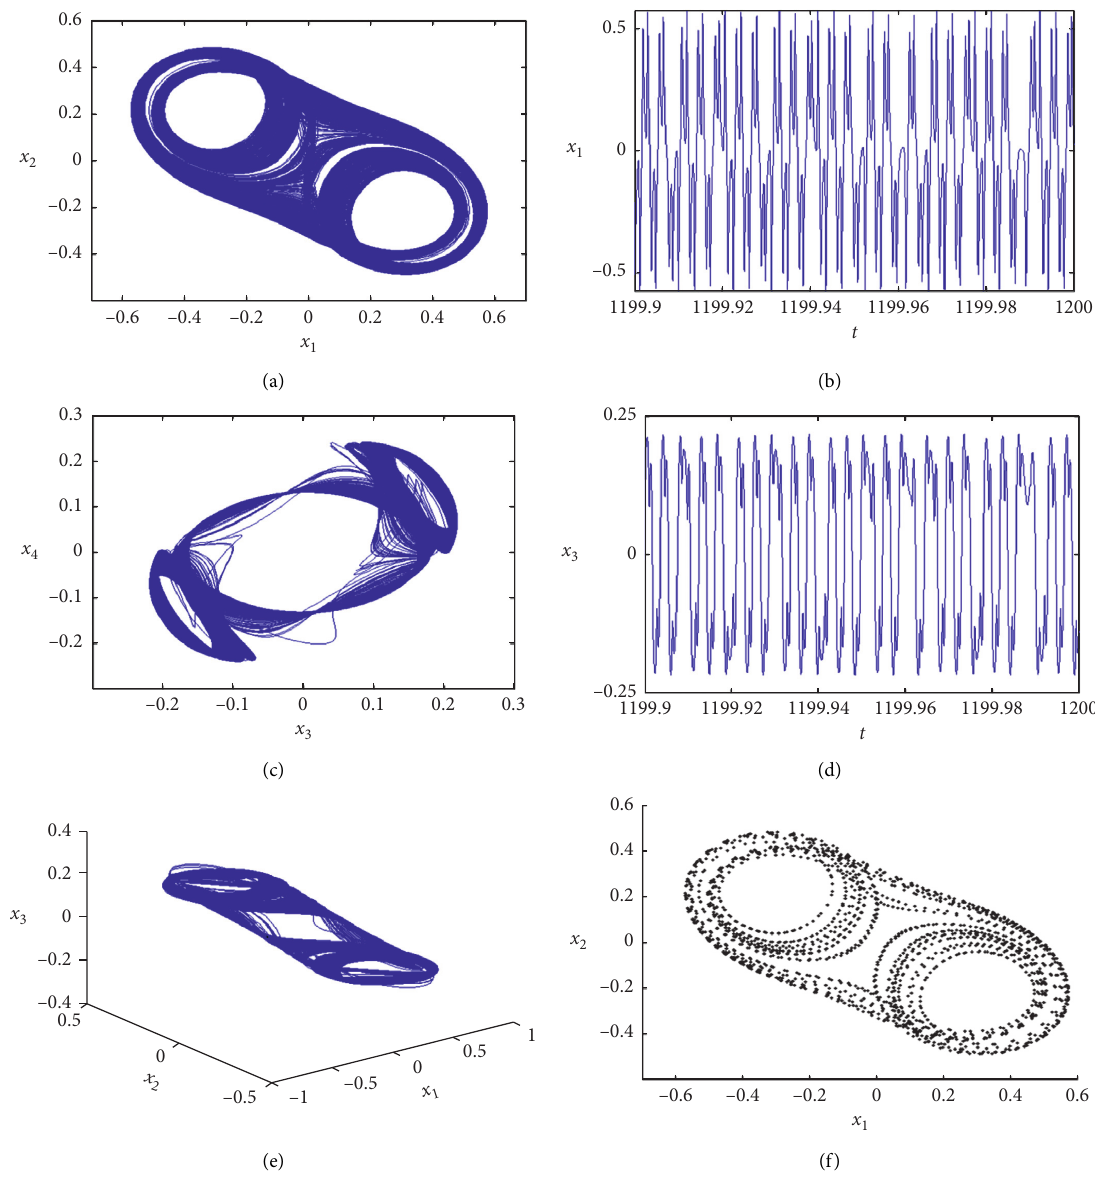
Figure 12: The chaotic oscillations of the cantilevered pipe conveying pulsating fluid are obtained when the parametric excitation of the flow velocity is U on plane ( t, x